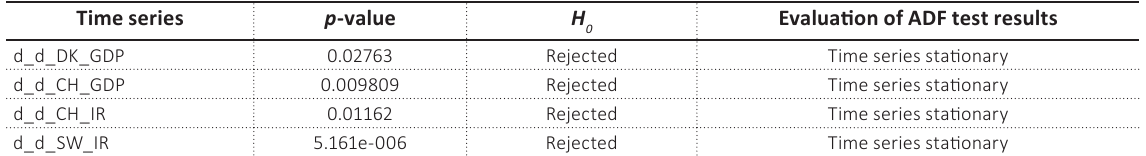
Table 7. The results of the ADF test – the second